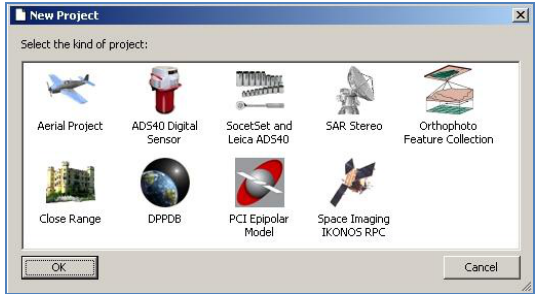
Fig. 4 Window of Summit Evolution showing the possible input data (Manual of Summit